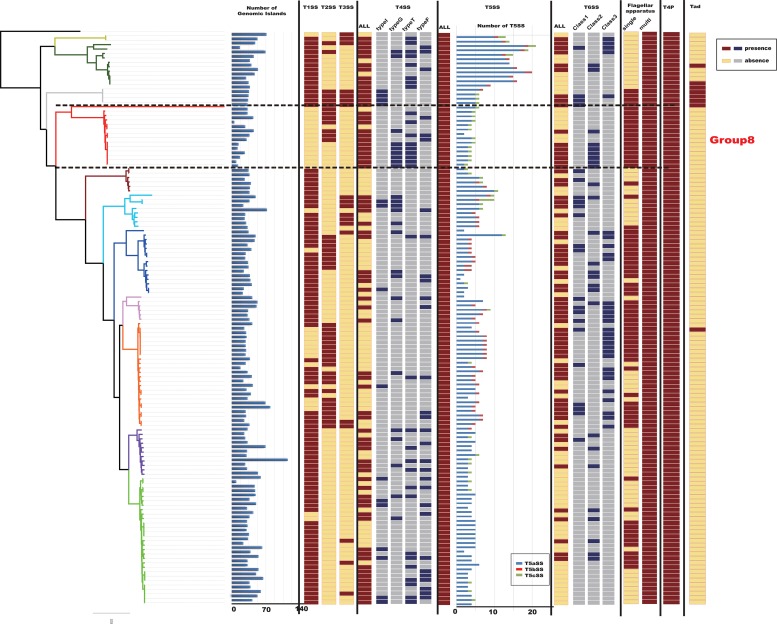
Macromolecular secretion system and genomic island (GI) distribution in Citrobacter strains. Dark red colors and blue boxes represent the presence of a macromolecular system within a genome, while gray colors and yellow boxes indicate the absence of a macromolecular system.